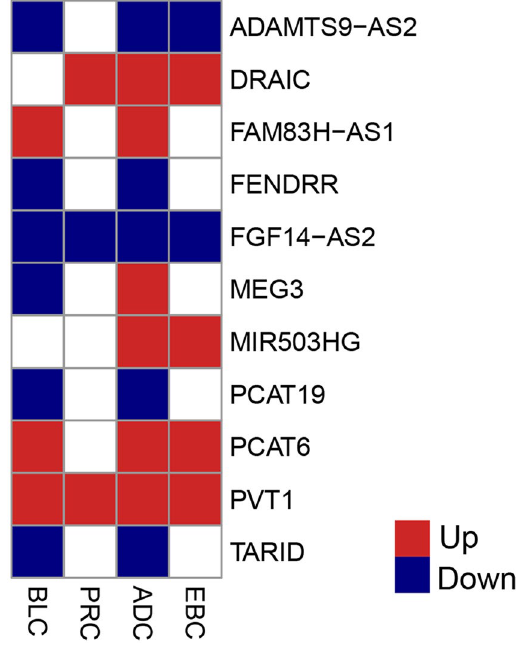
Figure 3. Heatmap of the eleven well-characterized onco-lncRNAs across all the four cancers. Red denotes up-regulation, and blue indicates down-regulation. Blank represents the gene which is not significantly dysexpressed in cancer.